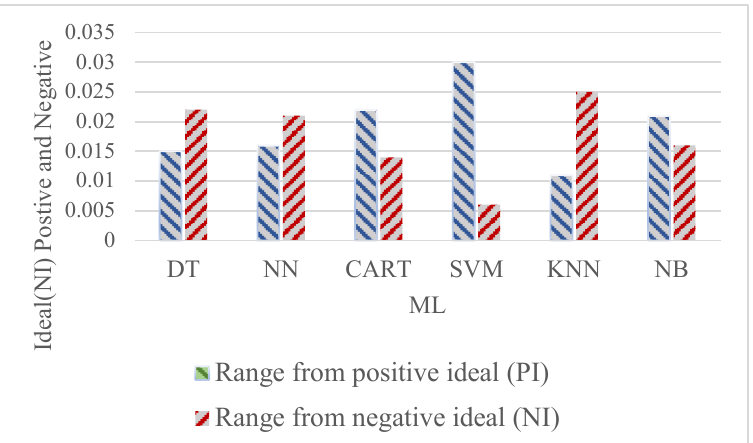
Table 8. Range from positive as well as negative ideal alternative solutions.